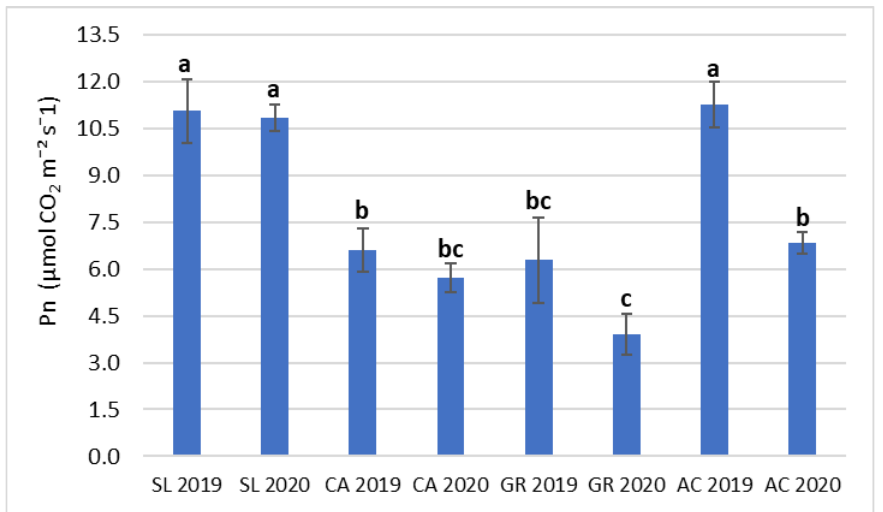
Figure 2. Combined effect of field and year (F x Y) on net photosynthetic rate (Pn) of V. vinifera subsp. vinifera ‘Falanghina’ vines at the four study sites: SL-Santa Lucia, CA-Calvese, GR-Grottole, AC-Acquafredde. Mean values and standard errors are shown. Different letters indicate significant differences according to Duncan’s multiple range test ( p ≤ 0.05).